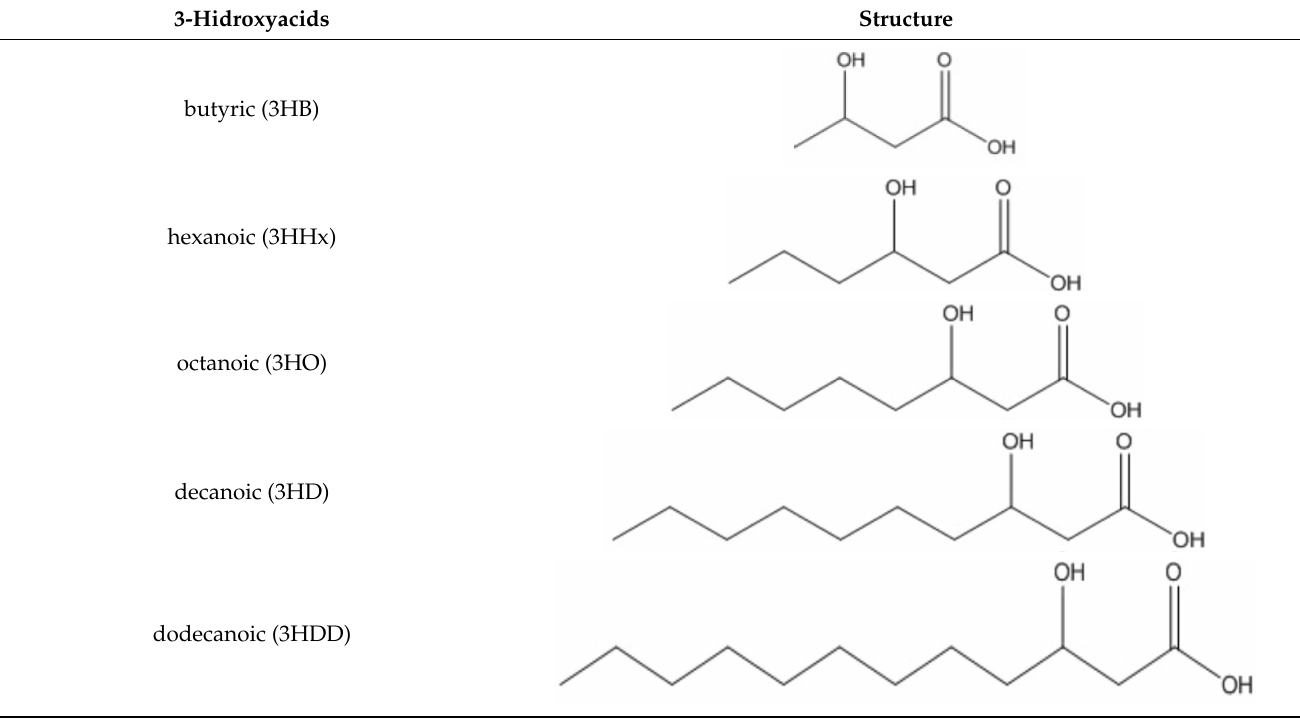
Table 1. Chemical structures of monomers described as units of PHA copolymer producing strains.